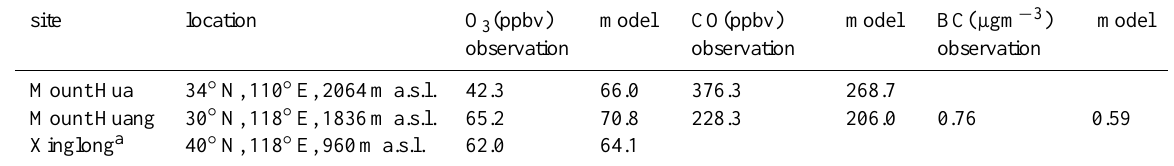
Table 3. Comparisons of monthly simulated and observed atmospheric pollutants at three Chinese sites in June 2006. site location O 3 (ppbv) model CO(ppbv) observation observation